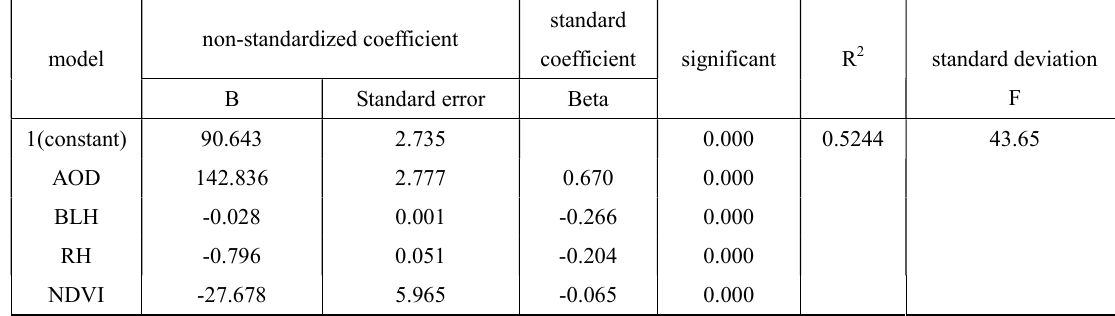
Table 1. Multiple linear regression model output